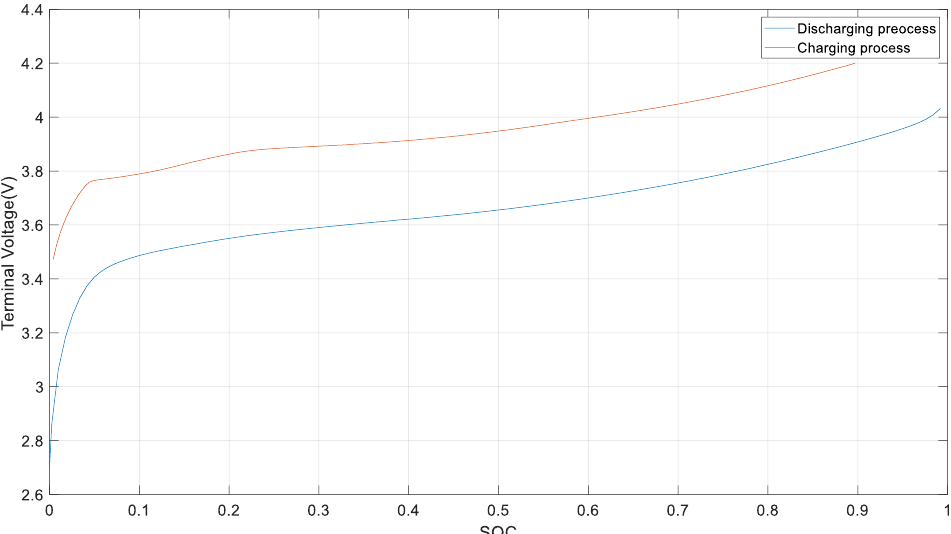
Figure 6. State of charge and terminal voltage curve during the charge-discharge process.